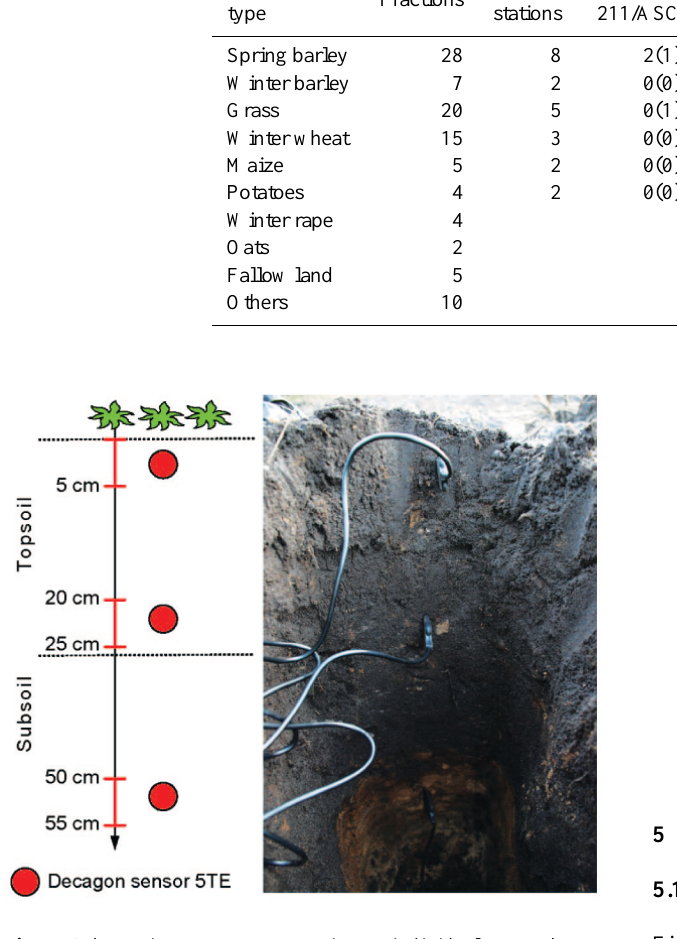
Fig. 5. Schematic sensor configuration at individual network sta- tions (left) using three Decagon 5TE sensors integrating soil mois- ture over ∼ 5cm depth intervals, respectively, and photo of soil profile with sensors installed according to the theoretical scheme